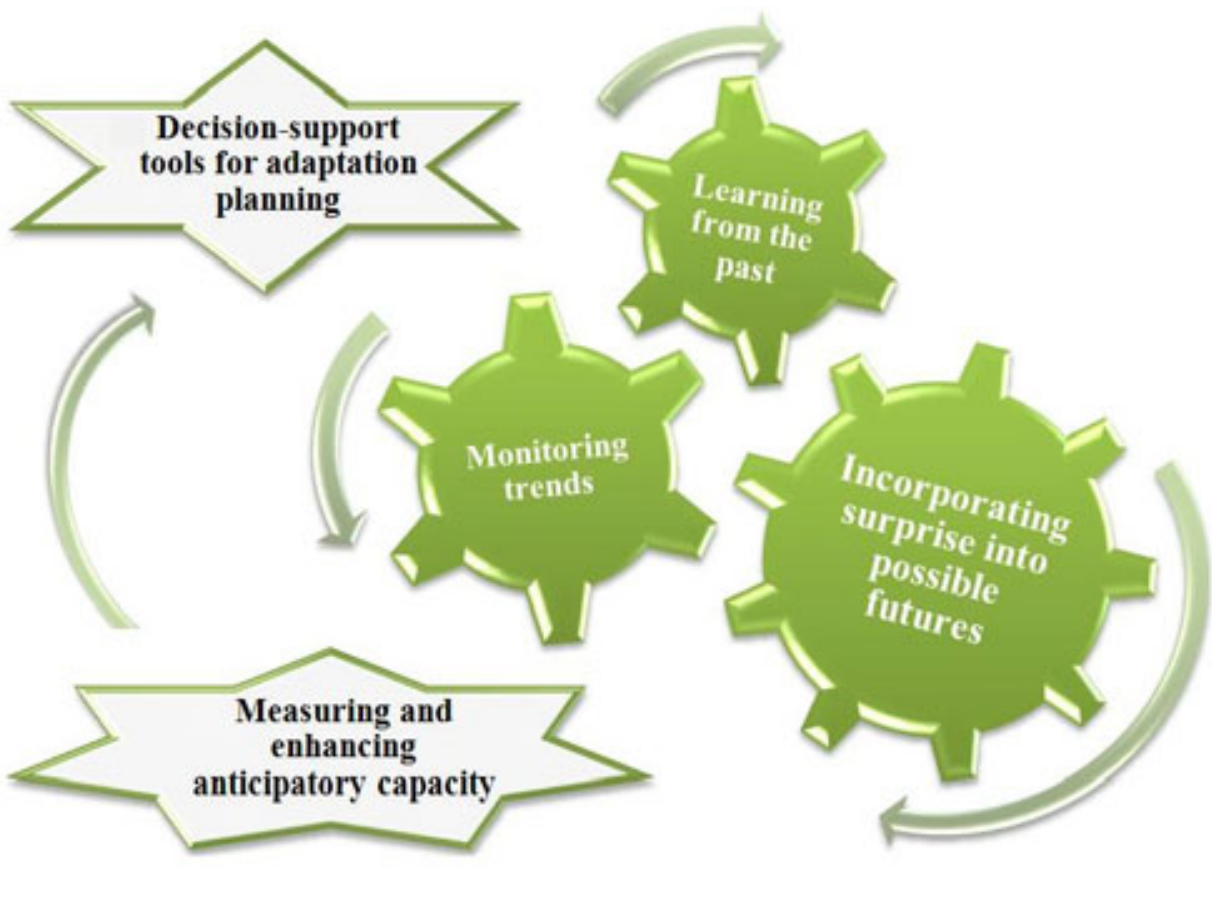
Fig. 6. Methodological framework depicting anticipatory learning for climate change adaptation with embedded cycles of critical reflection, anticipation, and